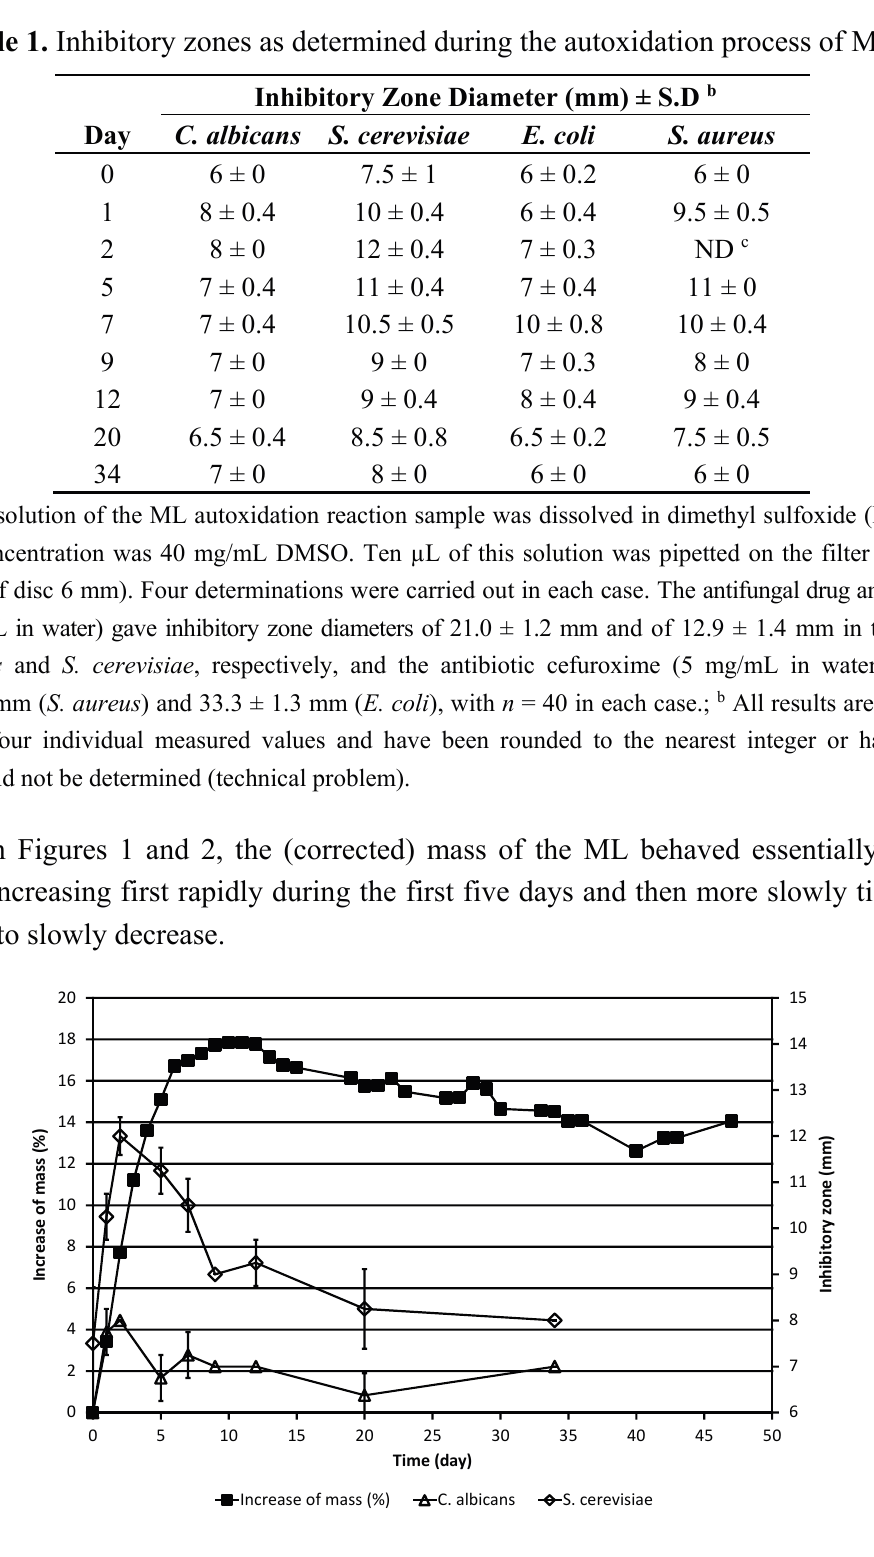
Figure 1. Increase of the corrected mass of the ML sample during the autoxidation process, as compared to the original mass, and the results of simultaneous determinations of inhibitory zones against the yeasts C. albicans and S. cerevisiae . The corrected mass of the ML was calculated using Equation (1). In cases where no error bar is shown for the inhibitory zone value, the standard deviation was